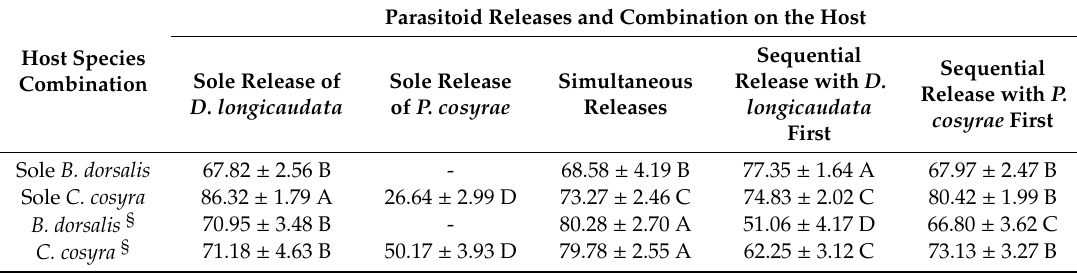
Table 3. E ff ect of combinations of Diachasmimorpha longicaudata and Psyttalia cosyrae on two fruit fly species Bactrocera dorsalis and Ceratitis cosyra mortality rates (mean ± SE%) under laboratory